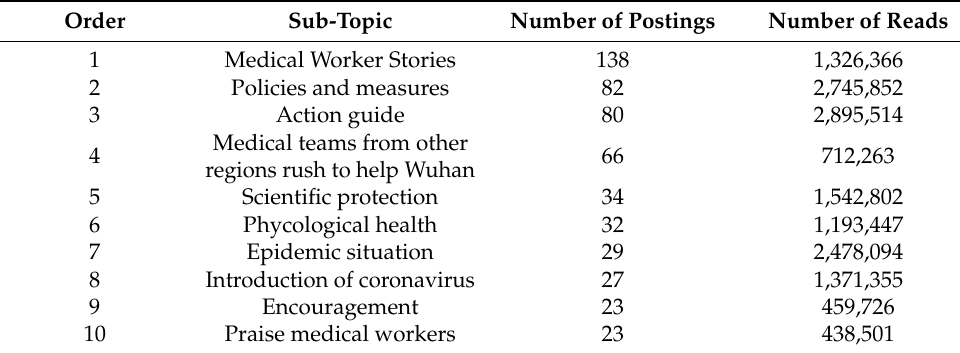
Table 3. Public attention (reads) on different sub-topics of the government at outbreak stage of COVID-19.